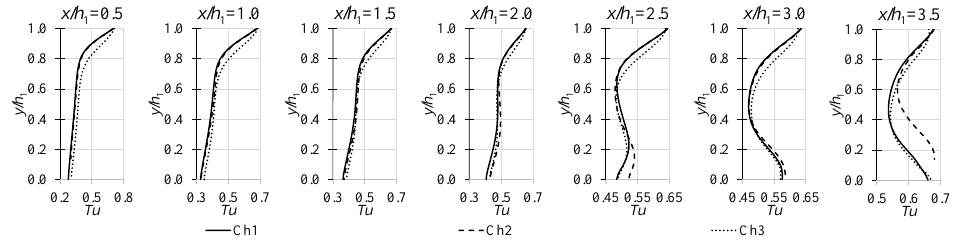
Figure 13. Turbulence intensity profiles along the cavity at Re = 1000.